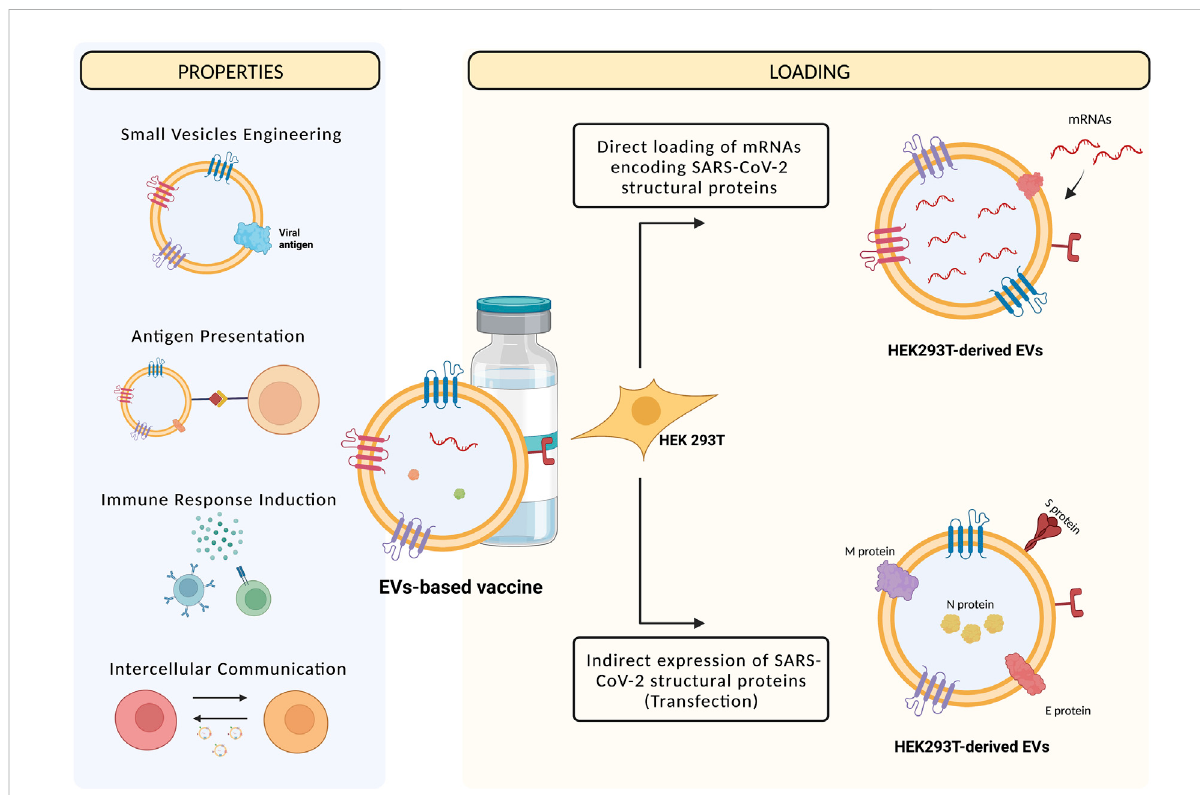
FIGURE 3 Next to being mediators of intercellular communication, EVs can present antigens and induce immune responses, and then being engineered to express viral proteins and used as vaccines. The methods currently used to realize EVs-based vaccines are the transfection of HEK293T cells with vectors expressing SARS-CoV-2 structural proteins, then expressed by EVs that are recognized by the host immune system, or the direct loading of mRNAs encoding for the SARS-CoV-2 proteins into EVs, that are then transferred to recipient cells that, in turn, are recognized by the host immune system. Created with